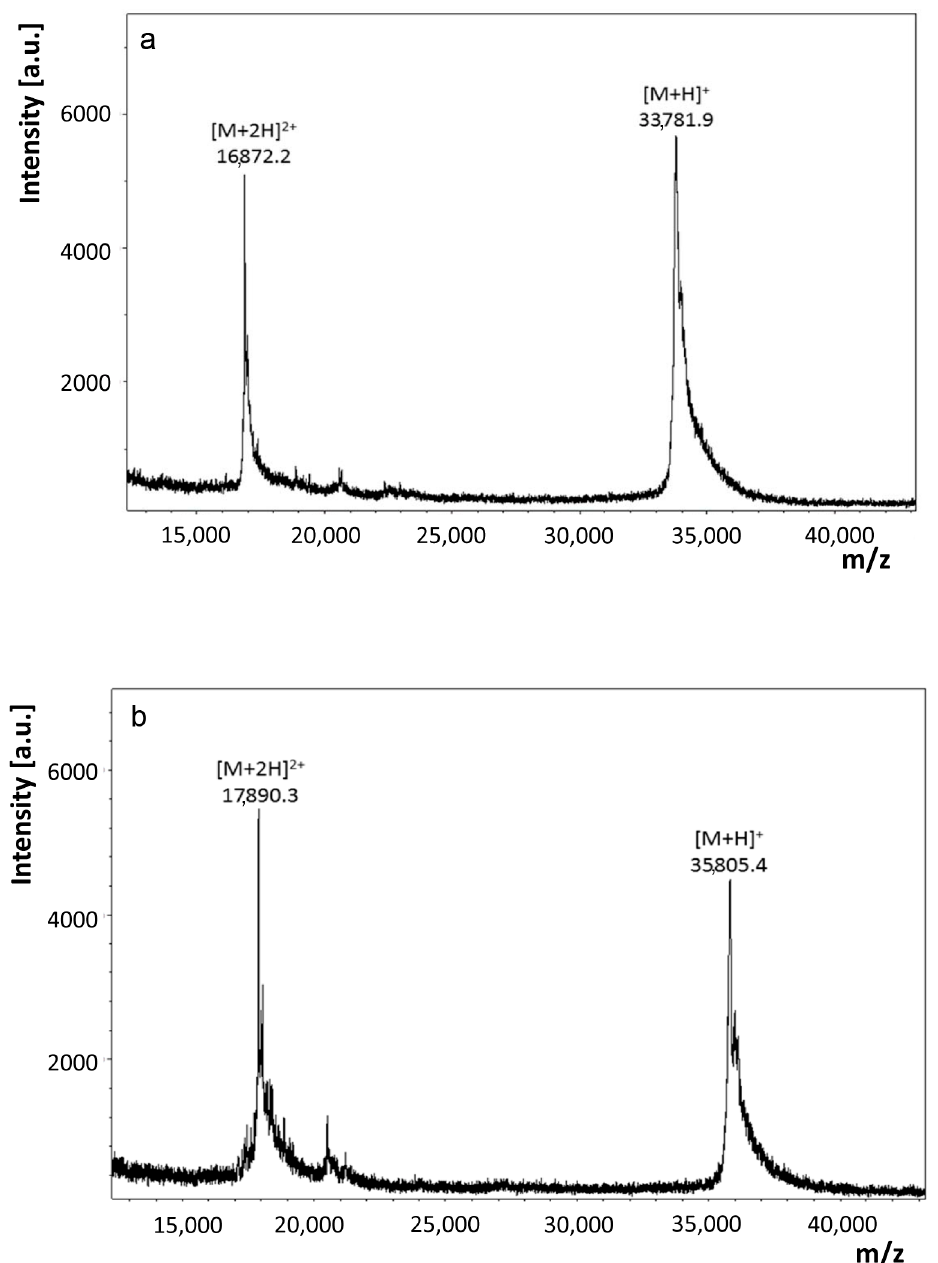
Figure 2. Mass determination of Gal-8 (NN) ( a ) and wild-type Gal-8S (NC) ( b ) by matrix assisted laser desorption ionization-time of flight mass spectrometry (MALDI-TOF MS). The two peaks represent the singly and doubly charged molecular ions of the studied protein.